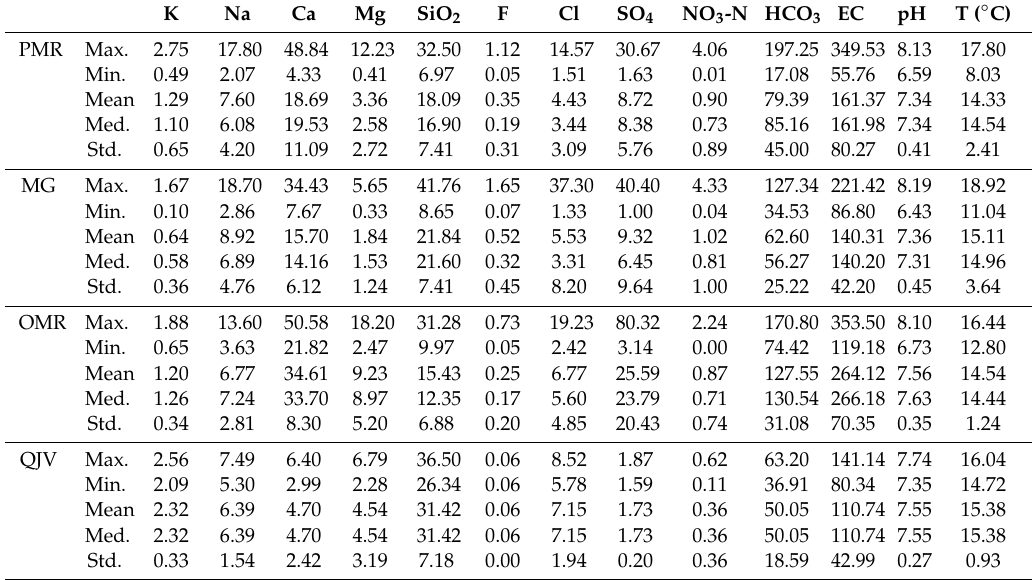
Table 2. Statistical comparison of physicochemical components in groundwater used for bottled waters, with respect to rocks (Precambrian metamorphic rocks (PMR), Mesozoic granite (MG), Ogcheon metamorphic rocks (OMR), and Quaternary Jeju volcanic rocks (OJV)). Min: minimum, Max: maximum, Mean: average, Med: median, Std: standard deviation. Units are the same as in Table 1.